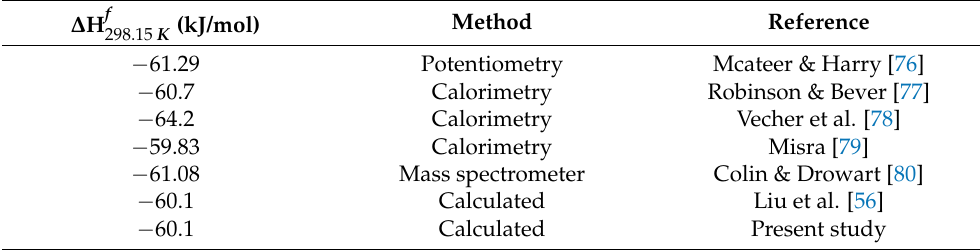
Table 2. Formation enthalpy of SnTe at 298.15 K.